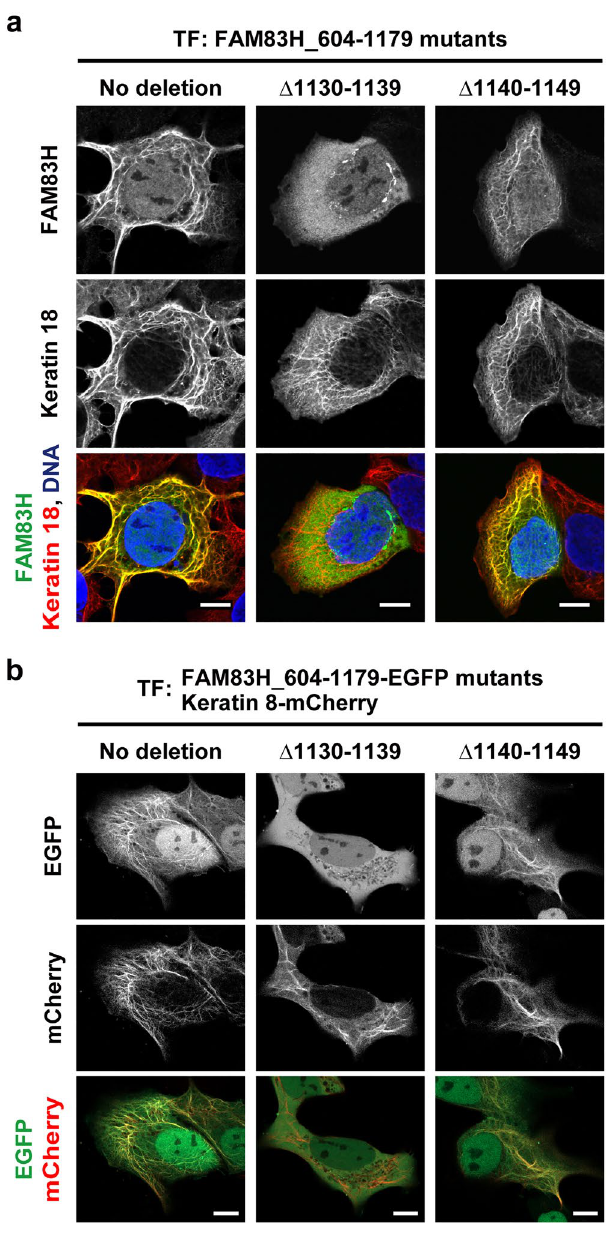
Figure 3. Deletion of 10 amino acid residues 1130–1139 of FAM83H results in its delocalization from the keratin cytoskeleton. ( a ) DLD1 cells were transfected with the plasmids encoding the indicated FAM83H mutants and were analyzed via immunofluorescence using antibodies for FAM83H (green) and keratin 18 (red). Nuclei were visualized by DAPI (blue). ( b ) DLD1 cells were co-transfected with plasmids encoding keratin 8-mCherry (red) and the indicated EGFP-fused FAM83H mutants (green) and analyzed via live cell imaging. Bars, 10